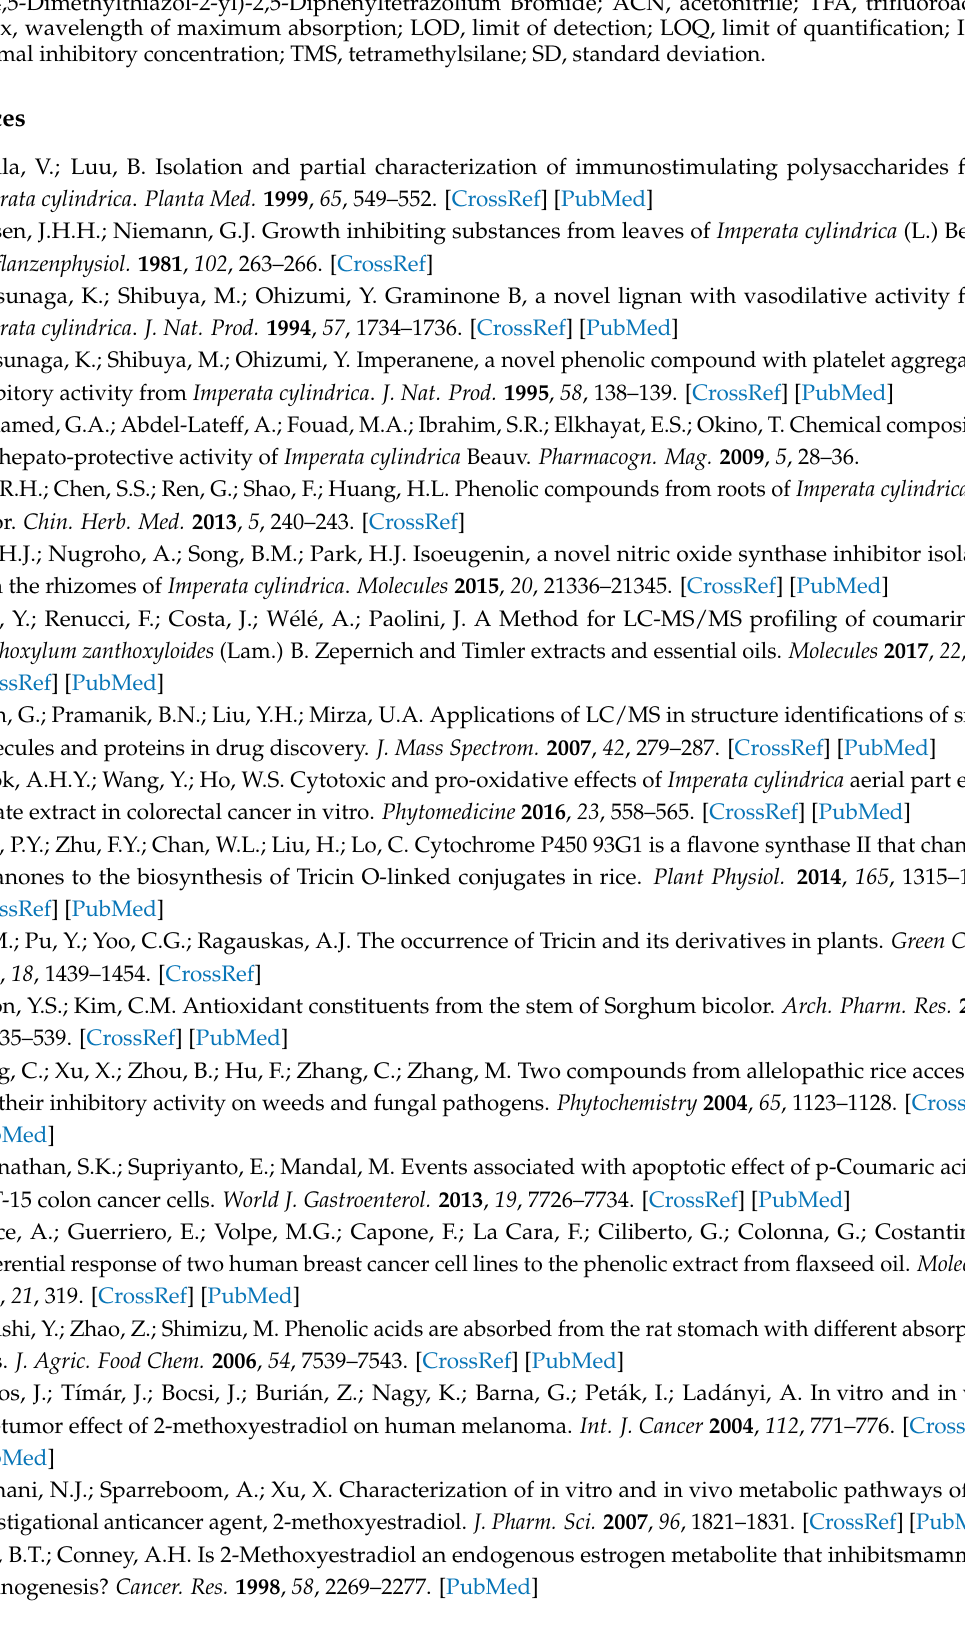
HPLC-DAD, high-performance liquid chromatography–diode array detector (HPLC-DAD); ESI-MS/MS, electrospray ionization tandem mass spectrometry; NMR, nuclear magnetic resonance; IMP, Imperata cylindrica; MTT, 3-(4,5-Dimethylthiazol-2-yl)-2,5-Diphenyltetrazolium Bromide; ACN, acetonitrile; TFA, trifluoroacetic acid; λ max, wavelength of maximum absorption; LOD, limit of detection; LOQ, limit of quantification; IC50, half-maximal inhibitory concentration; TMS, tetramethylsilane; SD, standard